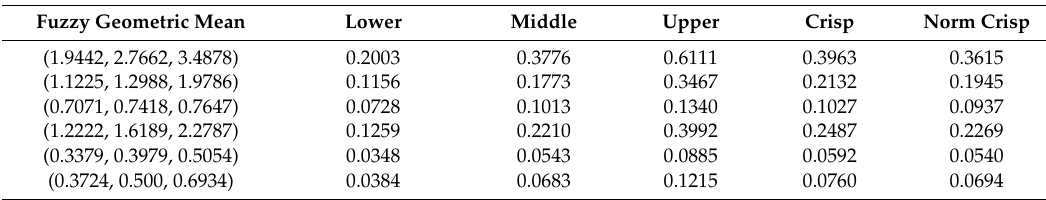
Table 10. Normalized fuzzy weights of criteria used in fuzzy TOPSIS.